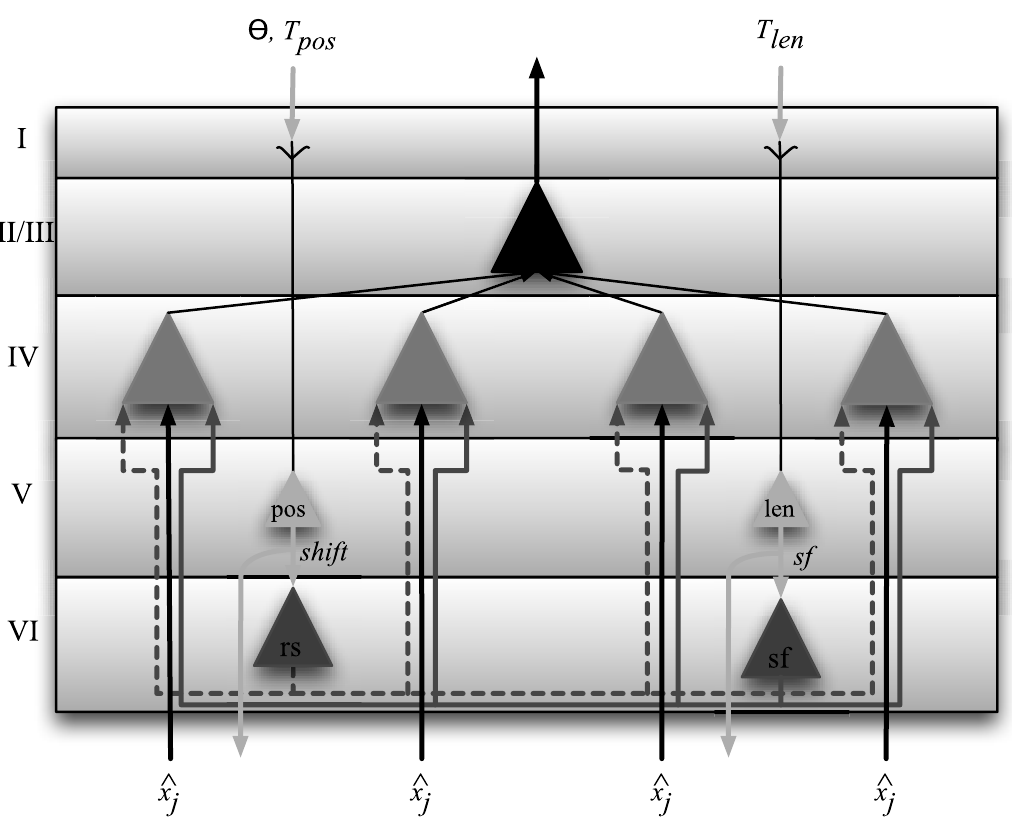
Figure 2. Laminar circuitry of attentional control in the ARC for a single column. Global attention signals that include the size ( T len ), position ( T pos ) and center of mass ( h ) are fed back from the next higher cortical level to layer-I where they ramify on apical dendrites of layer-V cells (see Equations 1–5). Layer-V neurons relay this signal to the next lower area with collaterals projecting to control neurons in layer-VI of that column where a sampling factor ( sf ) and relative shift ( rs ) are computed (see Equations 1 and 4 respectively). These signals, along with feedforward visual signals carrying image information b x j x j are received by layer-IV pyramidal cells where the routing function is computed in the dendrites and multiplied with b x j x j . Cells in layer-II/III pool the activity of multiple layer-IV neurons and project the gated signal to the next higher level. See text for additional